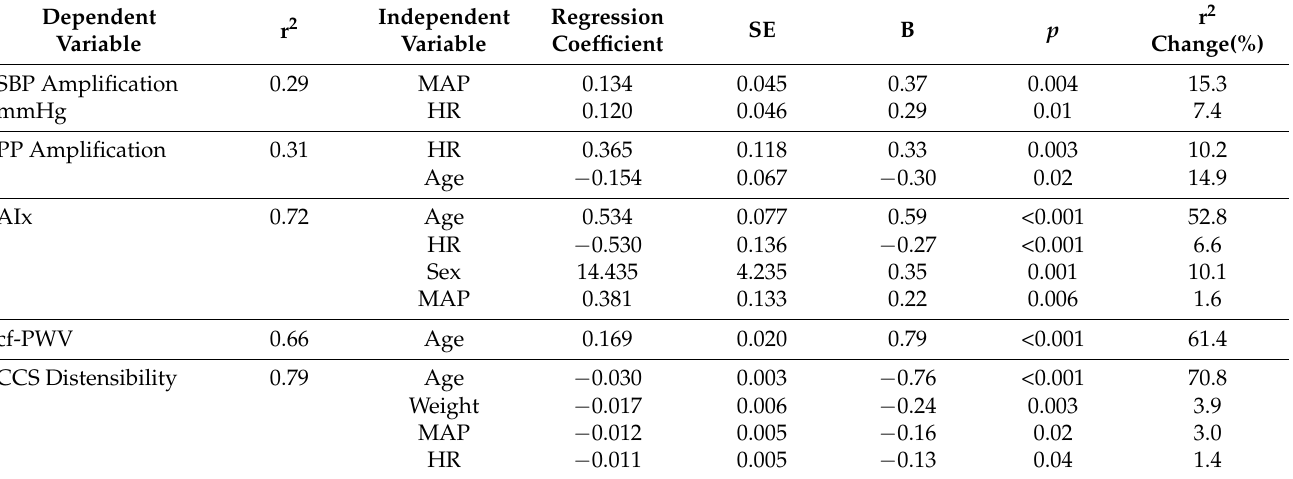
Table 4. Results of stepwise regression analysis with the main parameters for estimating arterial stiffness as dependent variables and anthropometric and clinical parameters as independent